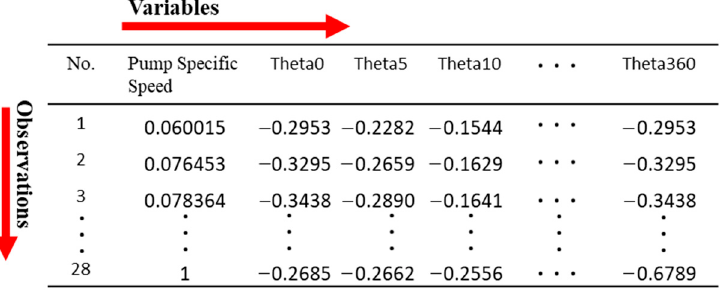
Figure 3. Representation of prepared dataset for training.